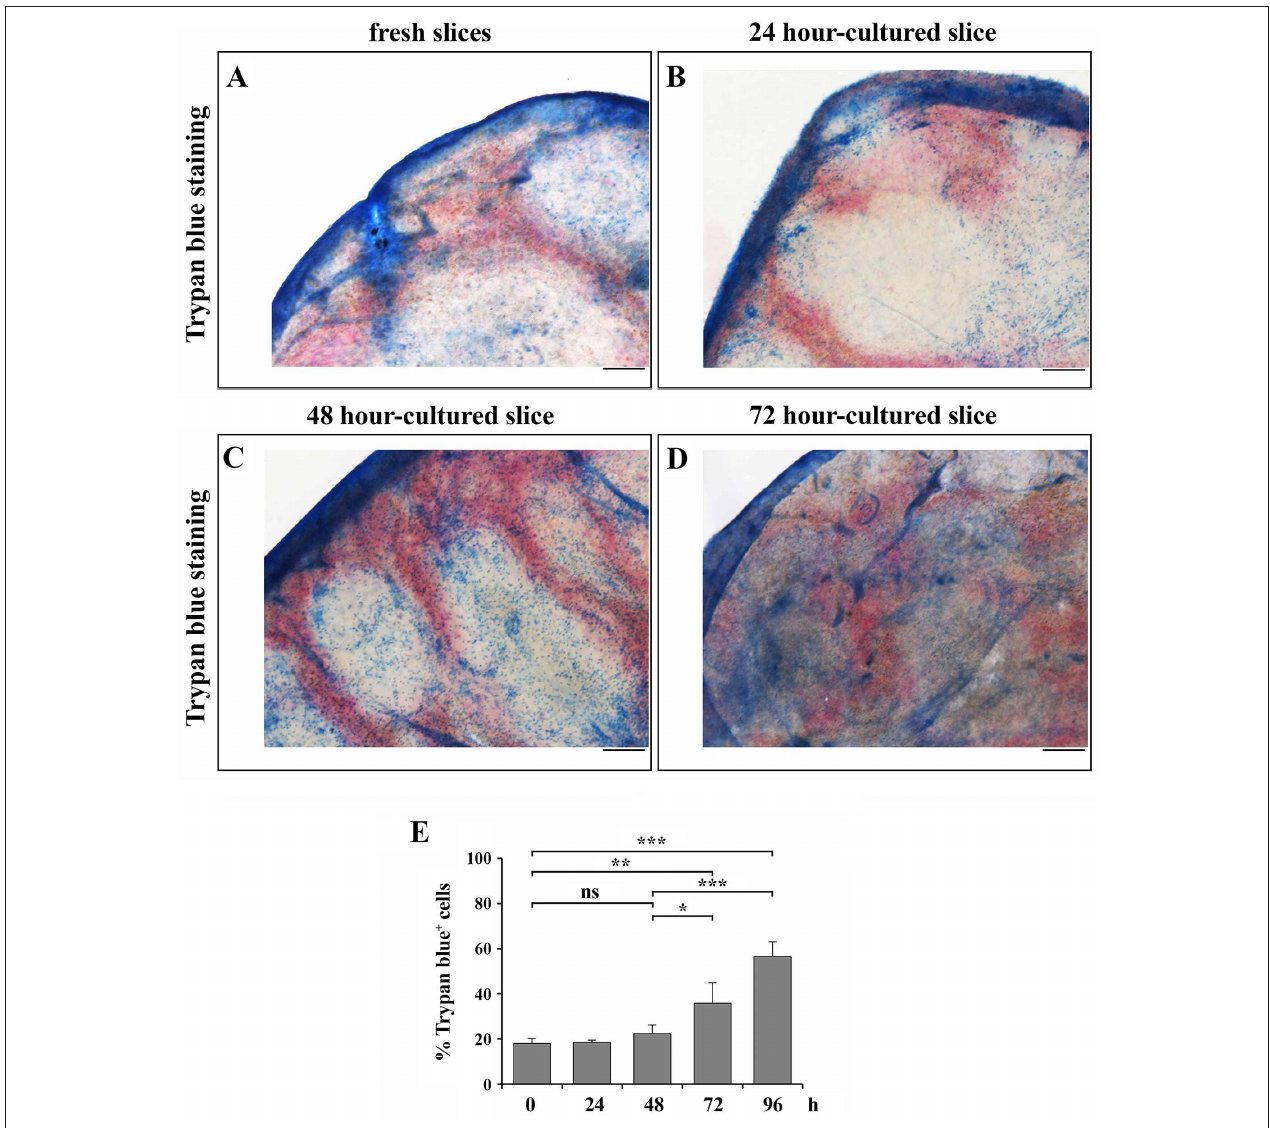
FIGURE 3 | 48 h-culture does not significantly increase cell death of spleen slices. (A–D) Optical microscopy pictures of spleen slices either immediately after cutting (A) or cultured in vitro for 24 (B) , 48 (C) , and 72 (D) h and stained with Trypan blue. Representative images are shown ( n = 3). Size bar, 200 µ m. (E) Trypan blue exclusion assay performed on spleen slices disgregated either immediately after cutting (0) or after in vitro culturing for 24, 48, 72, and 96h, stained with Trypan blue and counted by optical microscopy. The data are presented as the percentage of Trypan blue + cells over total cells ( n = 3). Mean ± SD. Student’s t -test; *** p ≤ 0.001; ** p ≤ 0.01; * p ≤